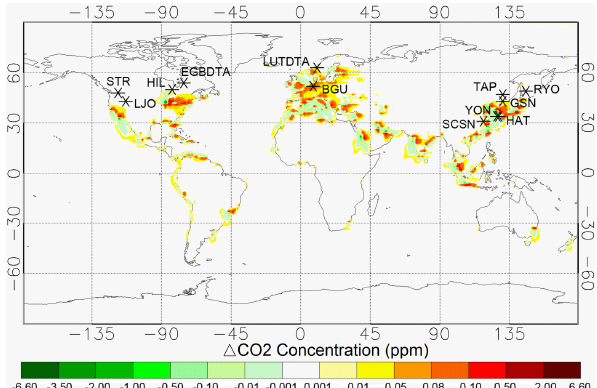
Figure 4. Simulated PCTM surface annual mean surface CO 2 con- centration difference (experiment minus control, units: ppm). The ∗ in the figure denotes existing CO 2 monitoring locations where the annual mean CO 2 concentration difference exceeds